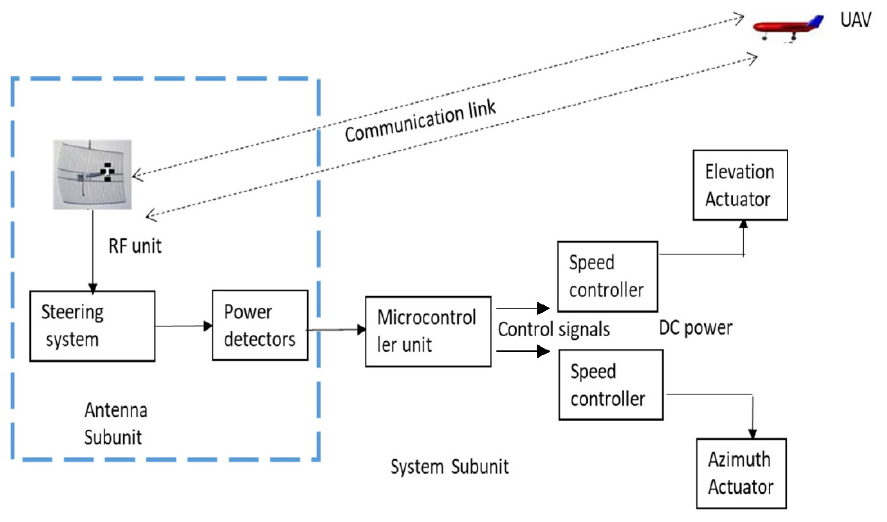
Figure 2. A UAV tracking antenna system.